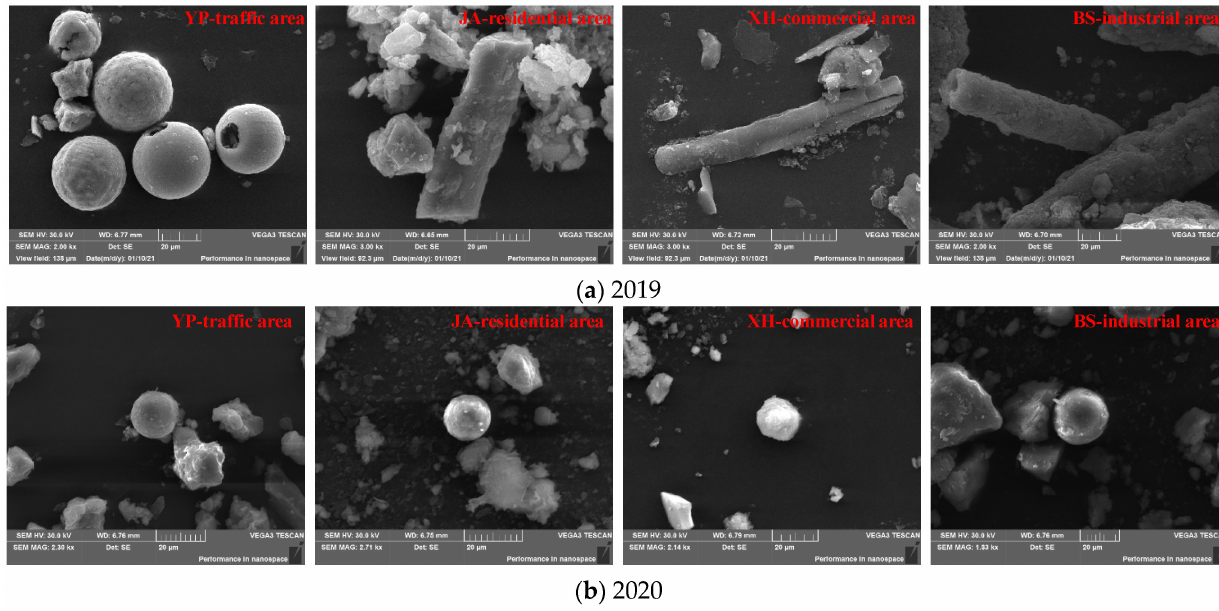
Figure 5. Morphology characteristics of typical dustfall